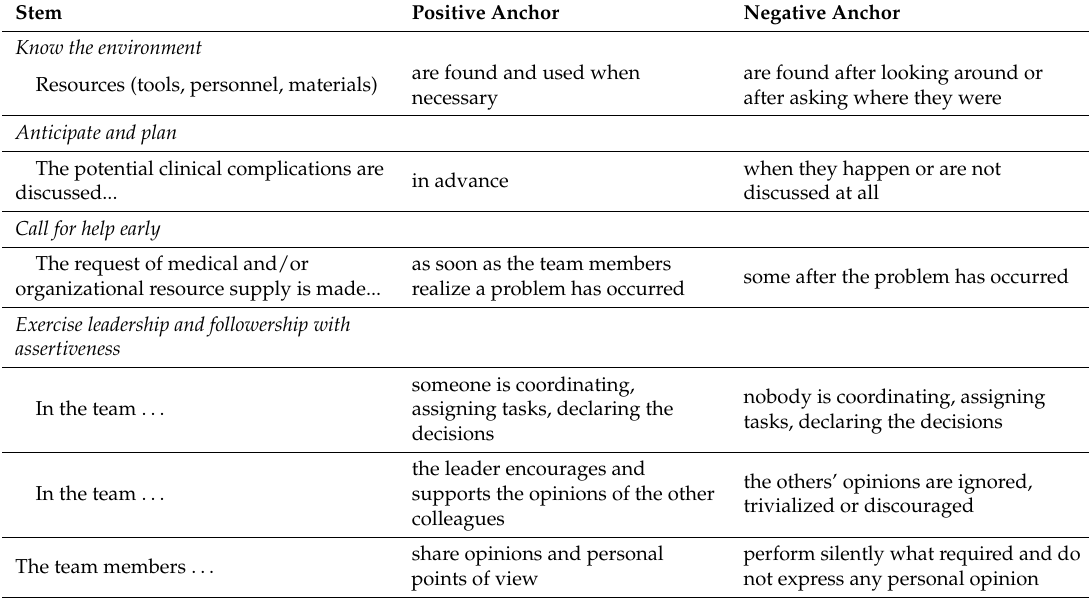
Table 1. Sample of behavioral markers for Crisis Resource Management (CRM) in the delivery room (for the complete list see the Supplementary